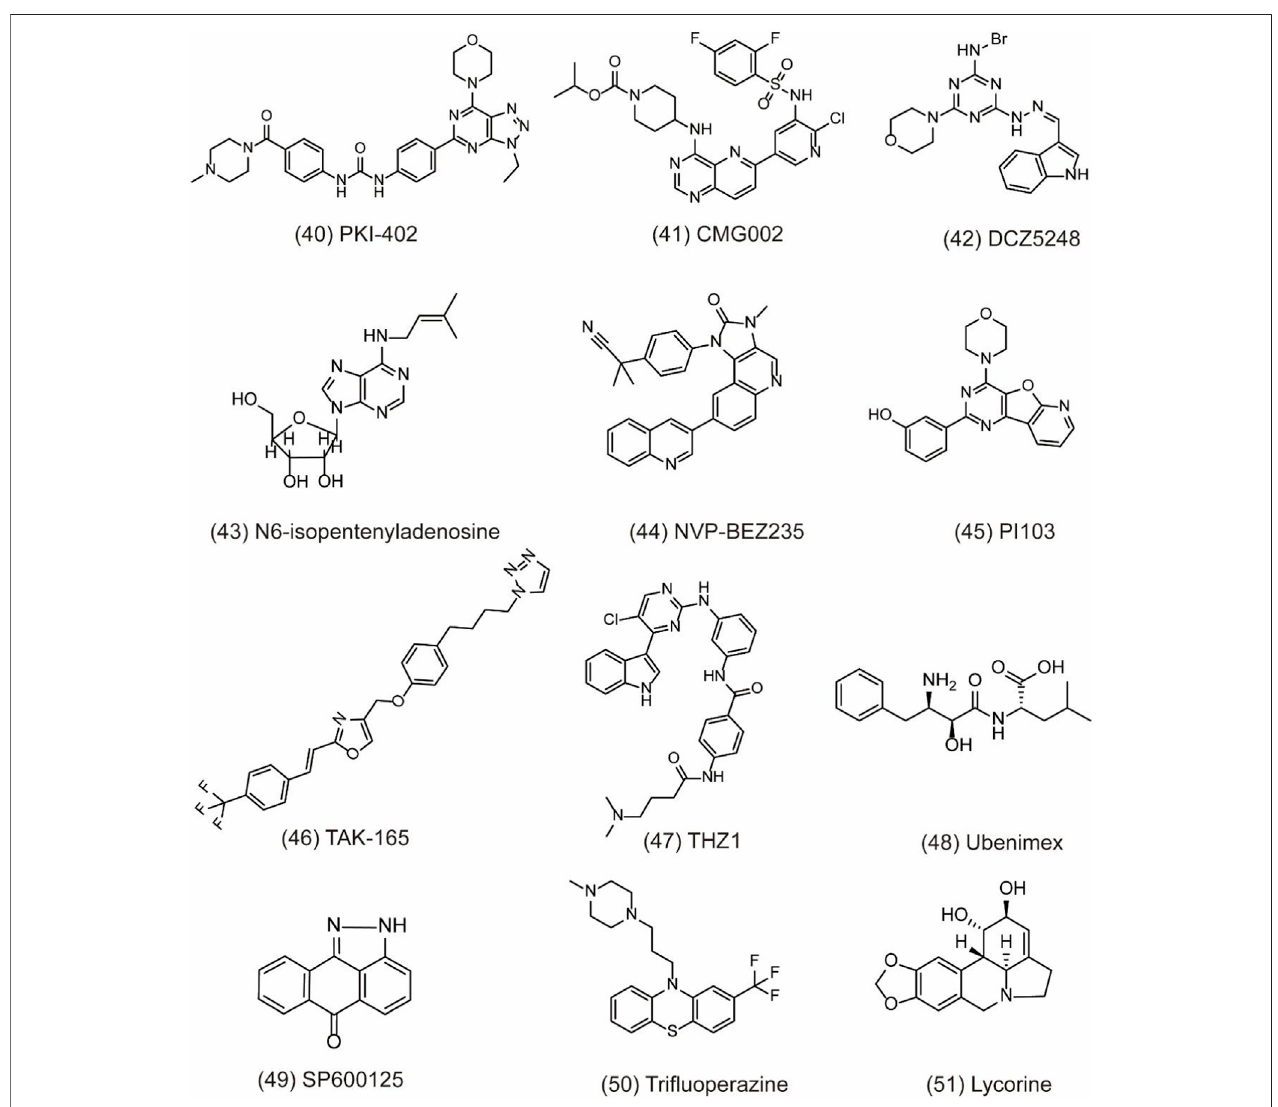
FIGURE 7 | Dual-target and combination strategies of small-molecule compounds of 40 – 51 as inhibitors of autophagy.